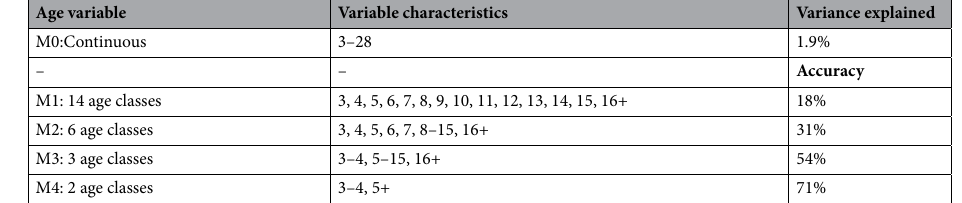
Table 1. Structure of the developed random forests models (M). We first developed a regression random forest algorithm, considering age as a continuous variable (M0), and subsequent random forests took age as a factor variable to set four age-classes divisions (M1–M4).